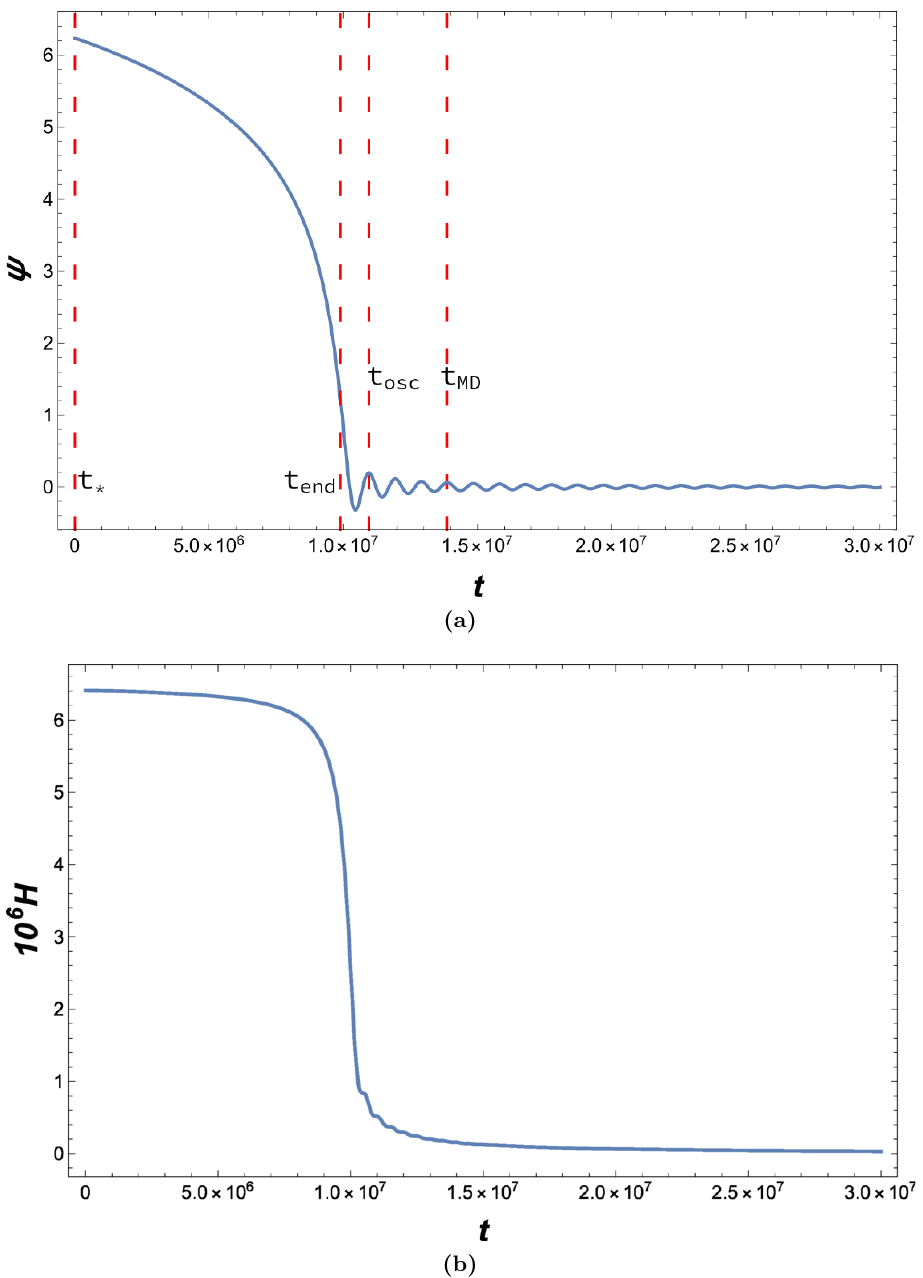
Figure 8. The numerical solutions for ( t ) and H ( t ), where we have set M P = 1. Note that t (cid:3) = 0 and t end ’ 9 : 89 (cid:2) 10 6 mark the beginning and end of the in(cid:13)ationary period. The times t > t end correspond to the post in(cid:13)ationary epoch. As de(cid:12)ned in the text, t osc ’ 1 : 096 (cid:2) 10 7 marks the time at which the potential energy is well approximated by V = 1 m 2 and t MD ’ 1 : 387 (cid:2) 10 7 is the 2 time at which our analytic solutions for and H become valid.